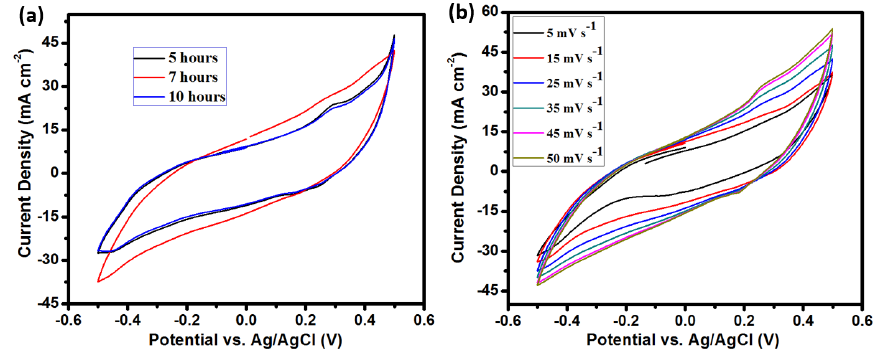
Figure 6. (a) Electrochemical performance of supercapacitors based on MnS coated on nickel foam with varying preparation times for 5, 7, and 10 h. ( b ) CV curves of MnS prepared for 7 h based supercapcitors for different scan rates in 2 M KOH solution.